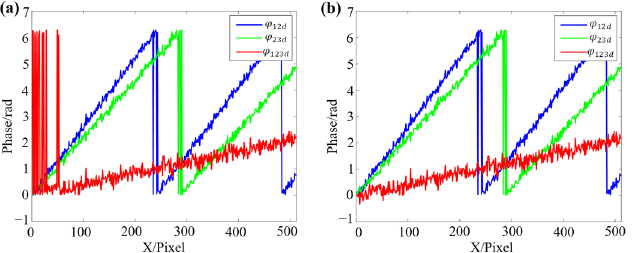
Figure 7. Comparison of the traditional and the proposed method in phase difference calculation. ( a ) The traditional method. ( b ) The proposed method.